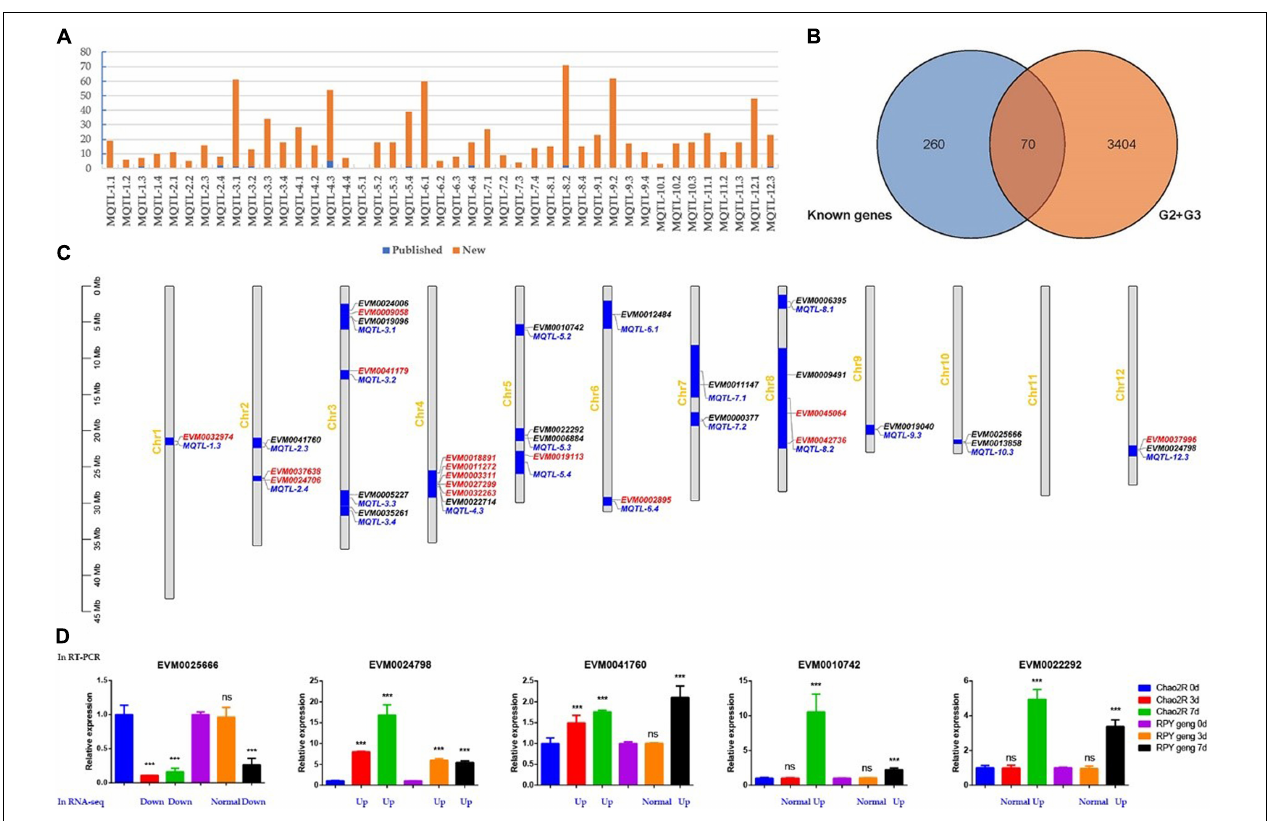
FIGURE 5 | Homologous genes of known genes in Meta-QTLs. (A) Statistics of known genes (red) and new genes (blue) of DEGs in each Meta-QTLs. (B) The venn analysis result of G2 + G3 and known genes. (C) Known genes (red) and homologous genes of known genes (black) in Meta-QTLs. (D) RT-PCR and RNA-seq results of five randomly selected candidate genes. G2 + G3 represented RPY geng specific DEGs in panel (B) ; Red, black, and blue represented known genes, homologous genes of known genes, and Meta-QTLs, respectively; Blue represented gene expression changes relative to the control of RNA-seq in panel (D) , details were provided in Supplementary Table 8 . ***means that the difference is significant relative to the control ( p < 0.001), and ns means that the difference is not significant compared to the control.